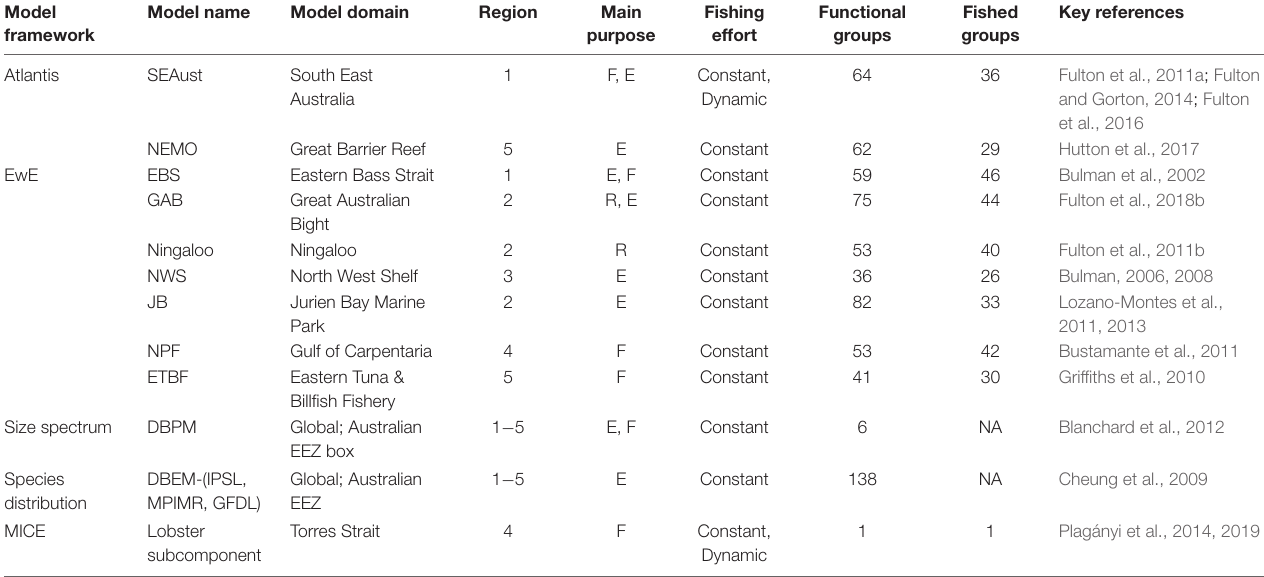
TABLE 2 | Summary of the regional and global ecosystem models used in this project to examine ecosystem responses to climate change and fisheries. NA indicates that fishing was not directly